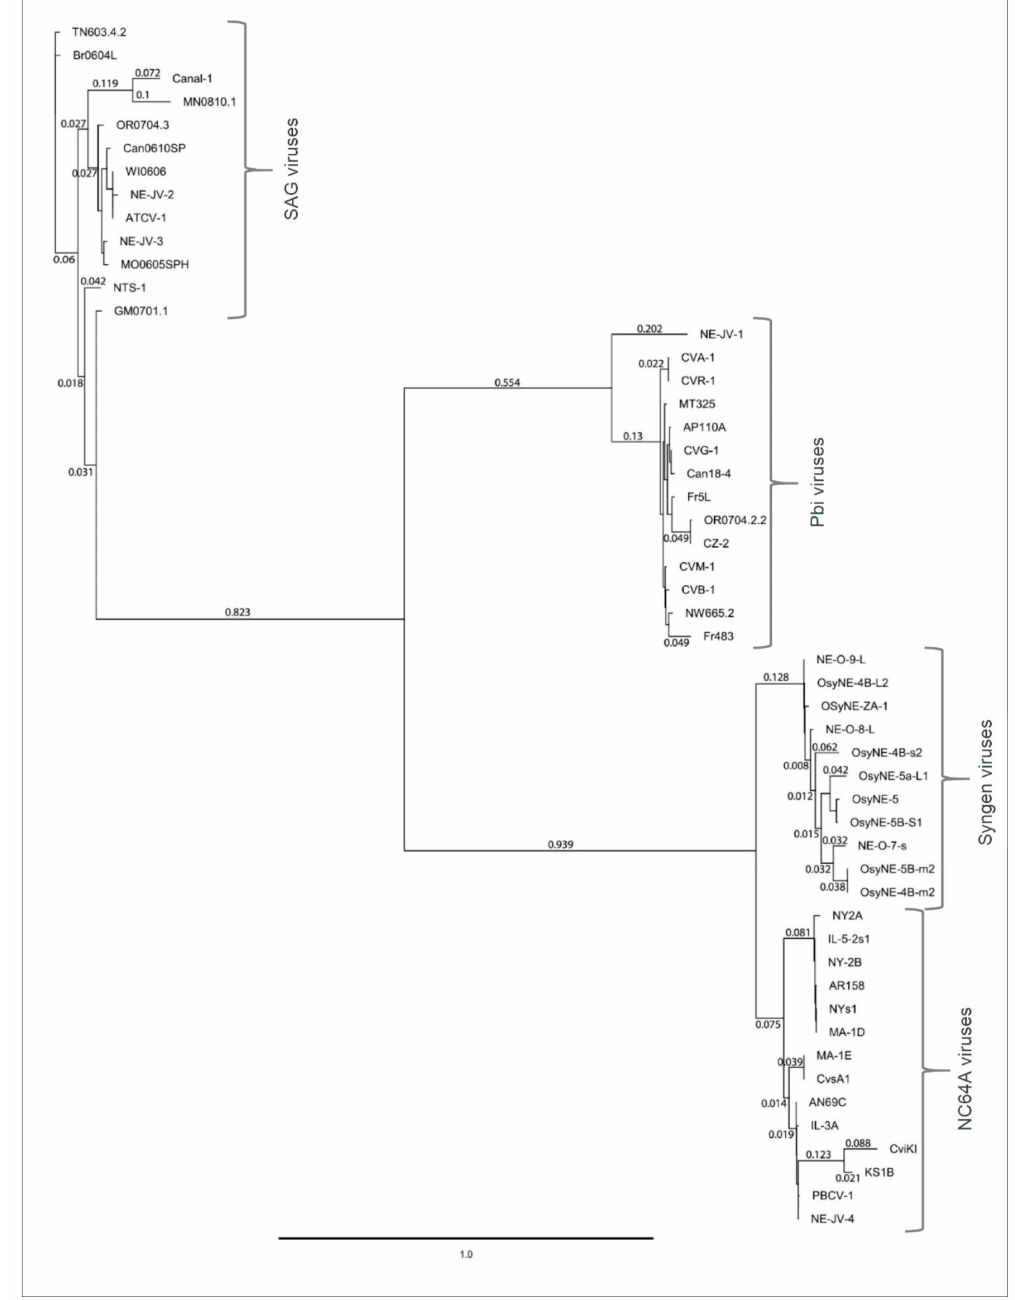
Figure 10. Phylogeny of A561L protein from 52 chloroviruses. Phylogenetic tree was constructed with Geneious plugin program PhyML 3.3.20180621 (Maximum likelihood) [33] using the default settings. The bar indicates the number of substitutions per site and branch length shows dissimilarity between